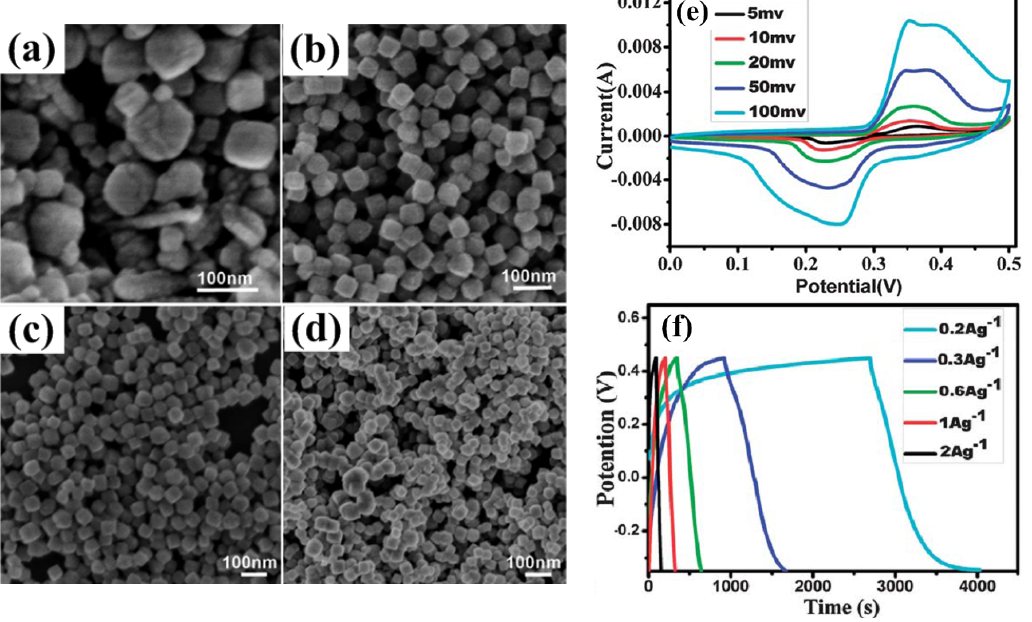
Figure 7. SEM images of Co 3 O 4 samples obtained by adding different concentrations of mesoporous carbon nanorods: ( a ) 0 mg·mL − 1 ; ( b ) 0.0175 mg·mL − 1 ; ( c ) 0.025 mg·mL − 1